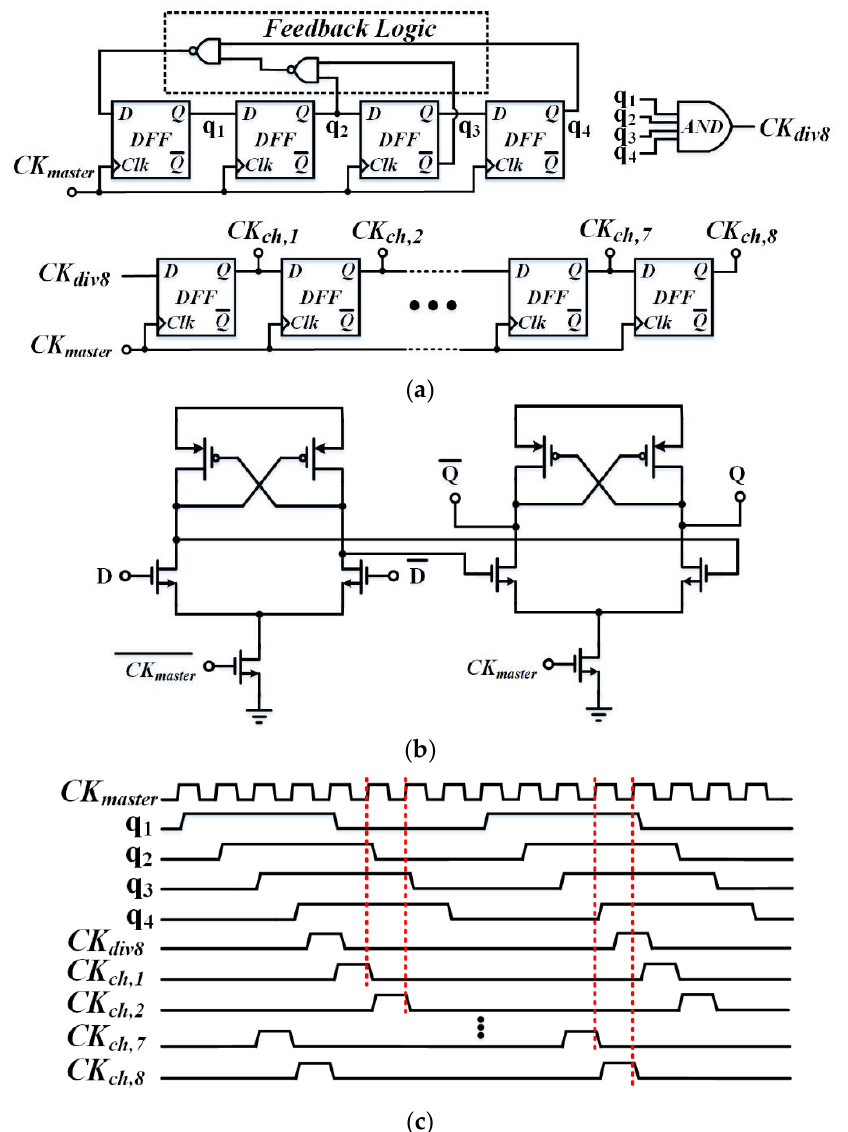
Figure 2. ( a ) Multi-phase clock generator (MPCG), ( b ) D flip-flop (DFF), and ( c ) timing diagram.